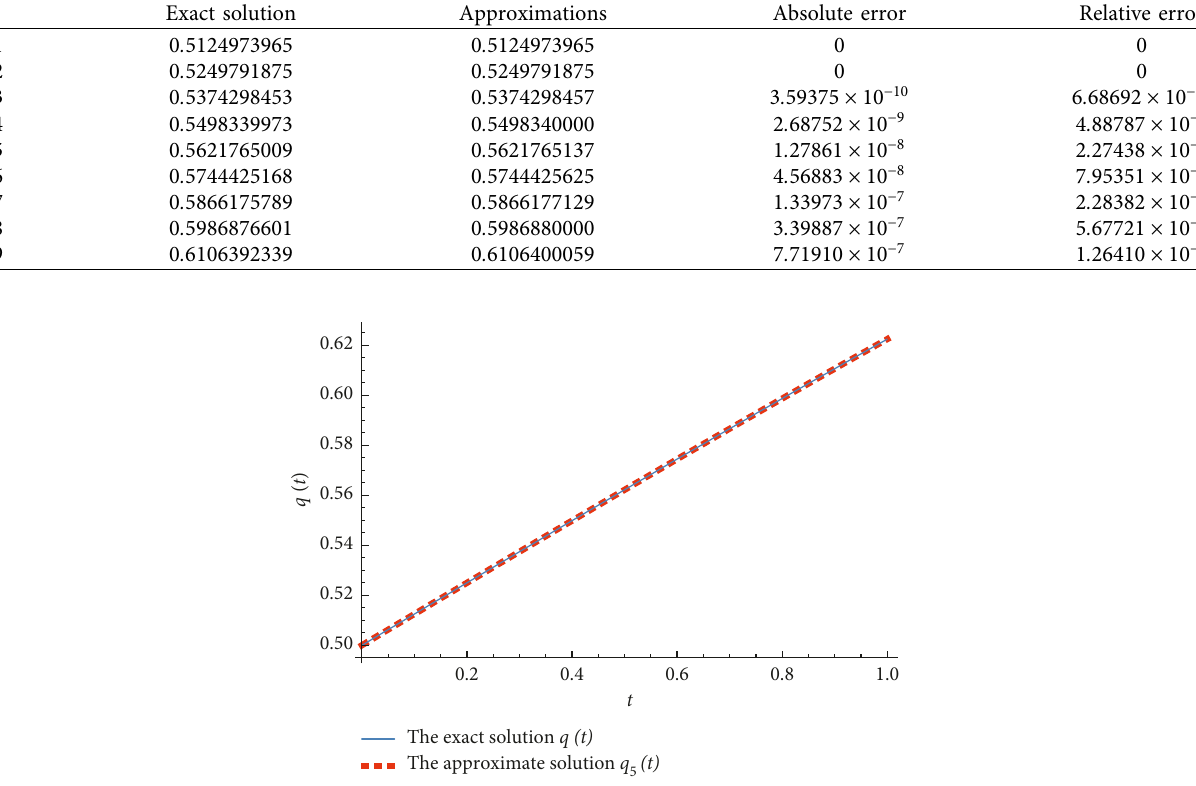
Figure 1: The behavior of FRPS solution at α � 1 for Example 1. Table 2: Comparison between the FRPS solutions and the OHAM [15] at α � 1 for Example